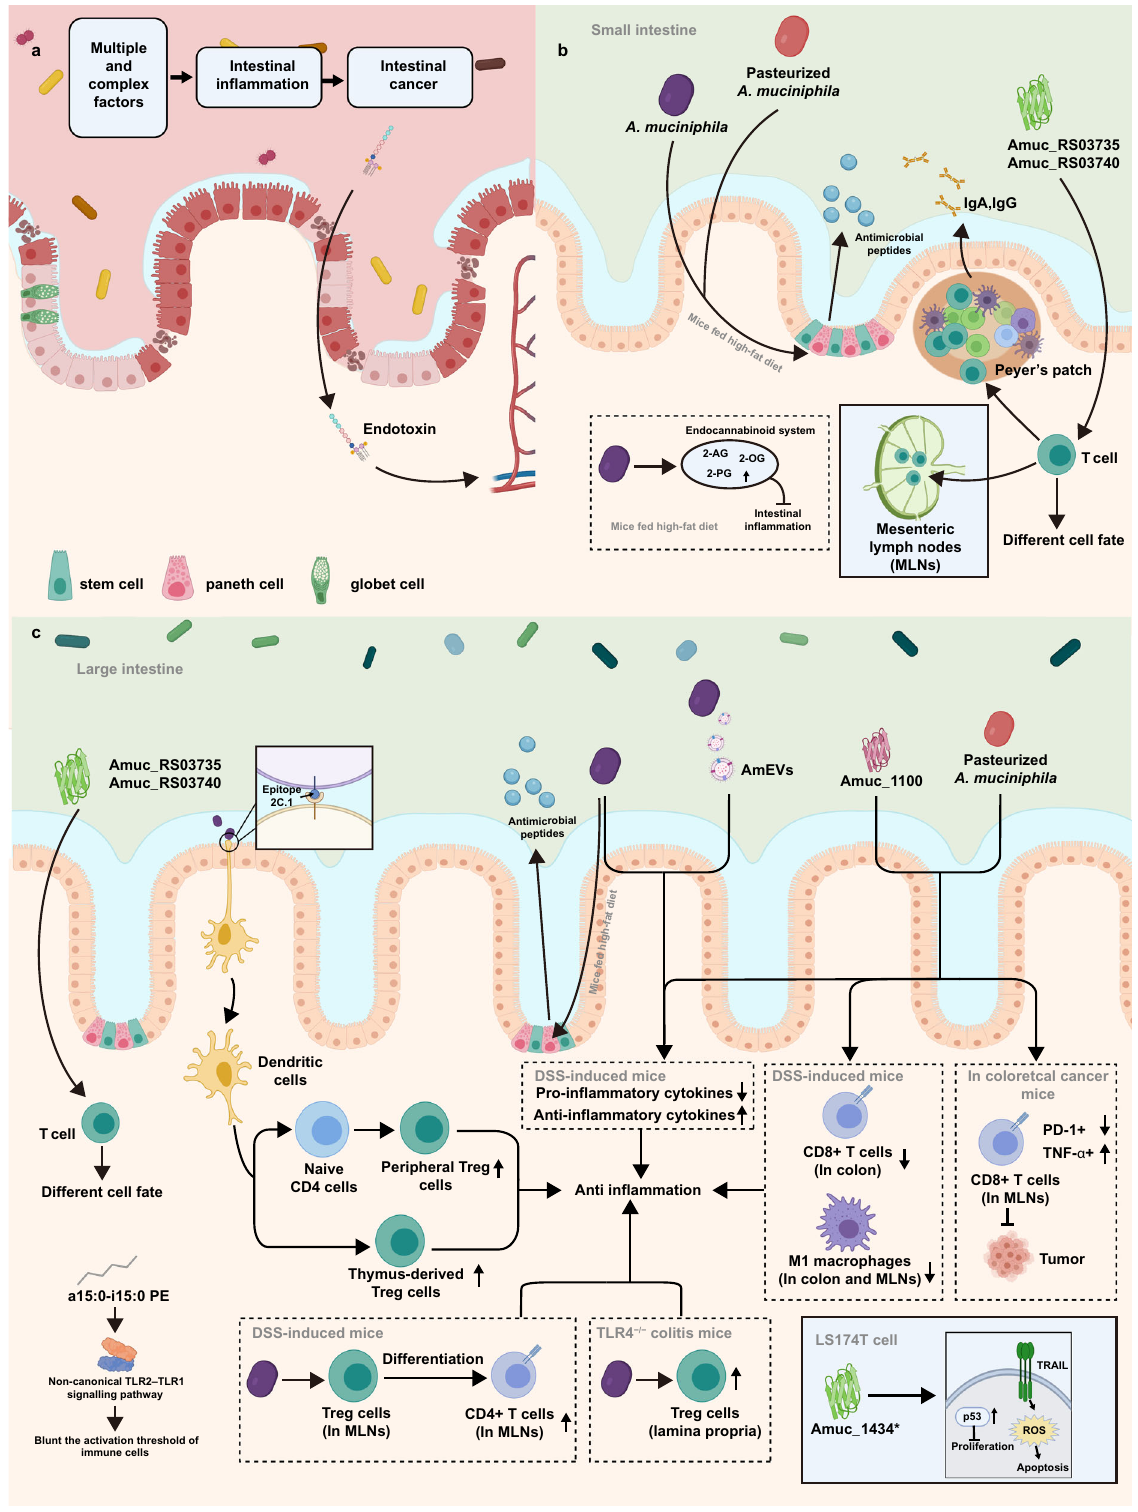
Fig. 3 The possible mechanisms of A. muciniphila regulating intestinal immunity in host with intestinal in fl ammation and colon cancer. All fi gures are created with